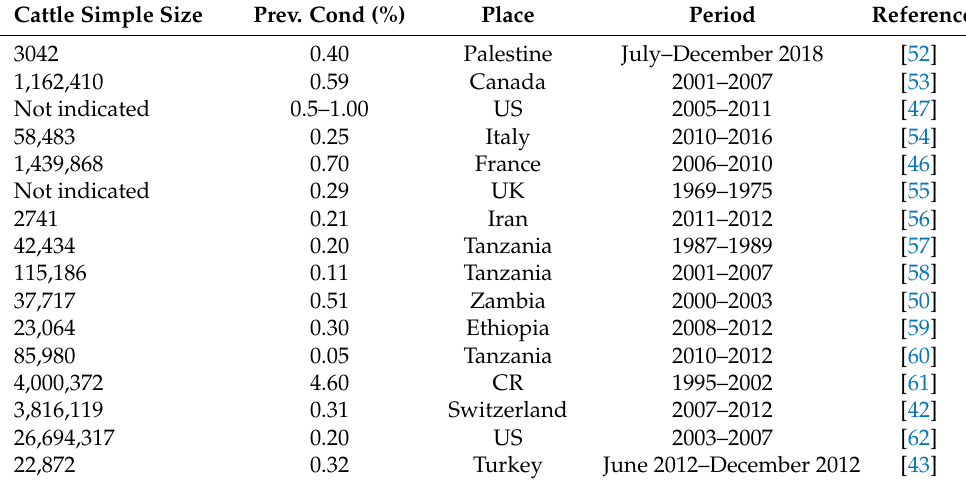
Table 1. Prevalence of cattle carcass